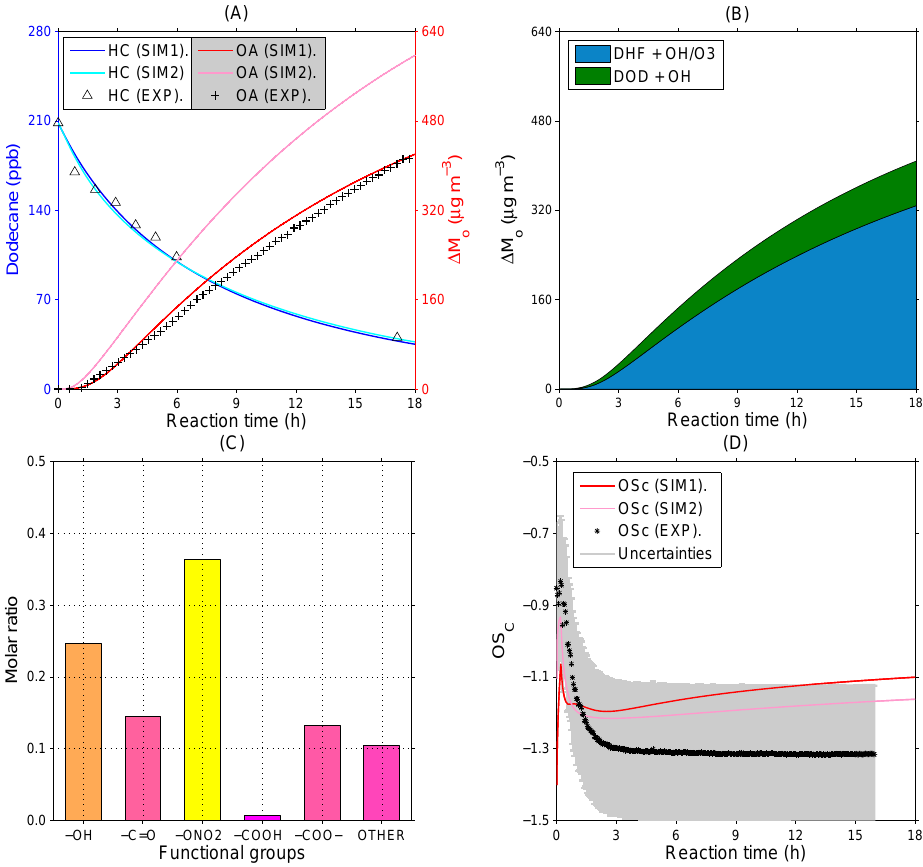
Fig. 11. (A) Comparison of the predicted dodecane decay and SOA growth with observations (Exp. 2). SIM1 represents the full mechanism simulations under initial conditions of Exp. 2. SIM2 is the simulations in the absence of the substituted dihydrofuran formation chan- nel. (B) The contribution of dihydrofuran chemistry (DHF + OH/O 3 ) vs. dodecane photochemistry (DOD + OH) to the total organic mass. (C) Molar fractions of major functional groups after 3h of photochemical reaction (when alkyl-substituted dihydrofuran peaks and organic loading is ∼ 50µgm − 3 ) as predicted by SIM1. Note that “other” includes dihydrofuran, tetrahydrofuran, and ether moieties. (D) Comparison of the predicted average carbon oxidation state with observations (Exp.